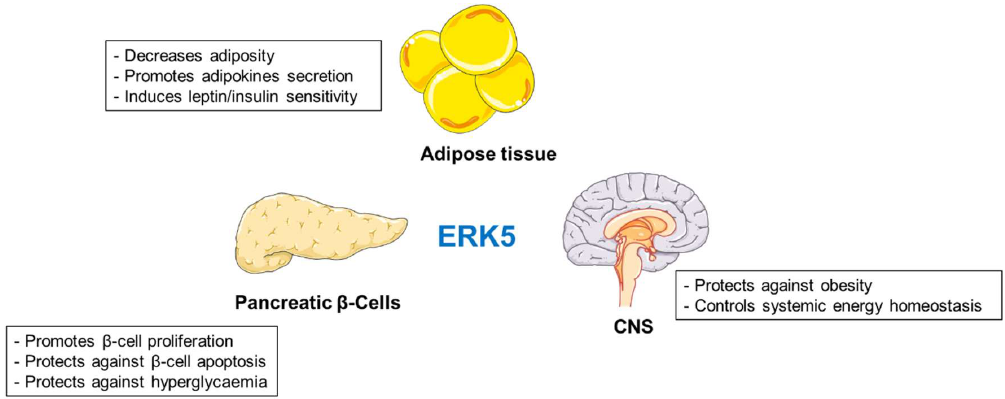
Figure 4. The impact of ERK5 on various tissues and organs.